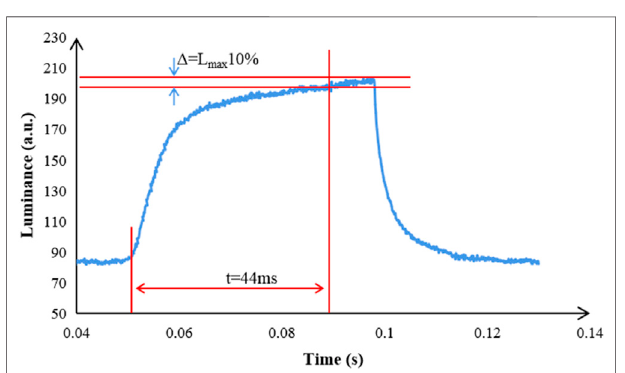
FIGURE 7 | The switch response curve of EWDs with a 30 V driving voltage and the calculation diagrammatic sketch of the constant E.